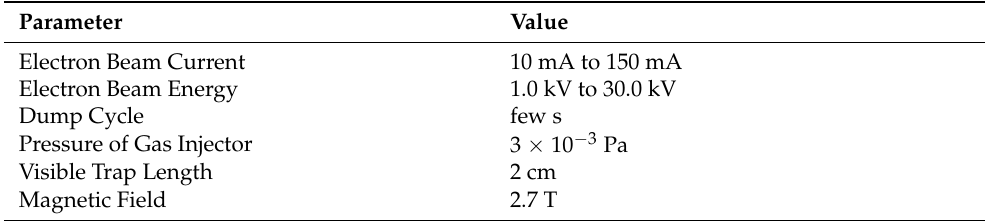
Table 1. Typical values of EBIT operating parameters at the NIST EBIT.